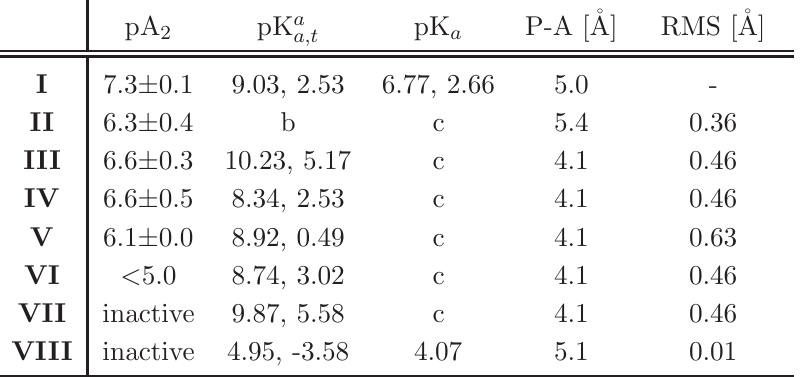
Table 1 Experimental α pK (measured), distances of the protonated nitrogen from the middle of the aromatic a ring P-A and RMS errors of geometric fit of the given substance with derivative I (see